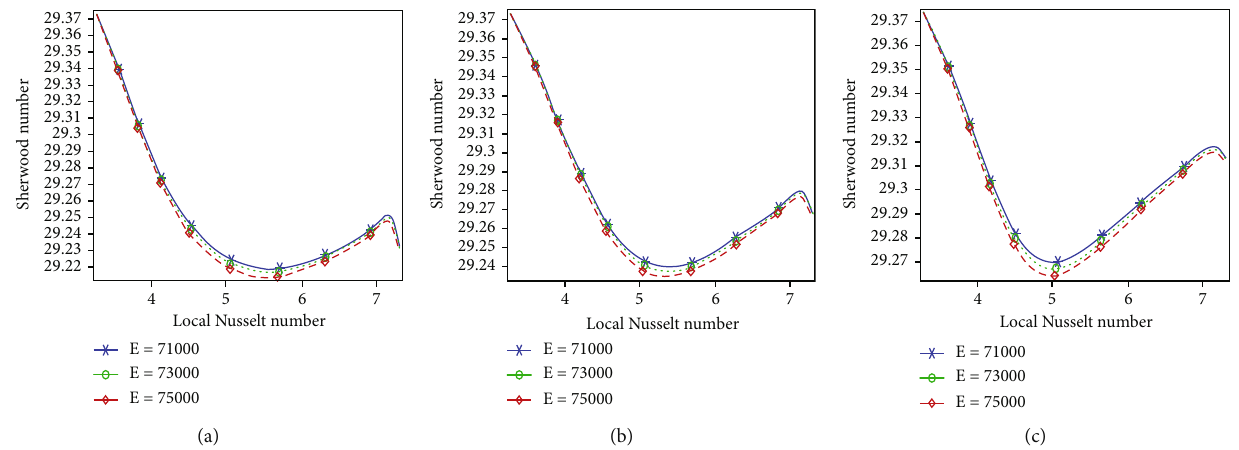
Figure 18: Sherwood number vs. the local Nusselt number at downstream along the backward step channel against the axial direction at (a) Re = 100 , I : C = 1 % , a = 0 : 5 ; (b) Re = 100 , I : C = 1 % , a = 0 : 6 ; and (c) Re = 100 , I : C = 1 % , a = 0 : 7 .